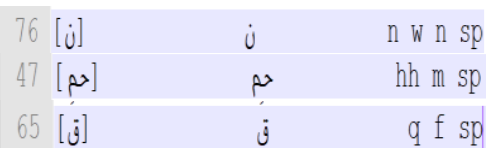
Figure 6. Sample of Level Transcriptions, ( a ) words Level Transcriptions, and ( b ) Phone Level Transcriptions.